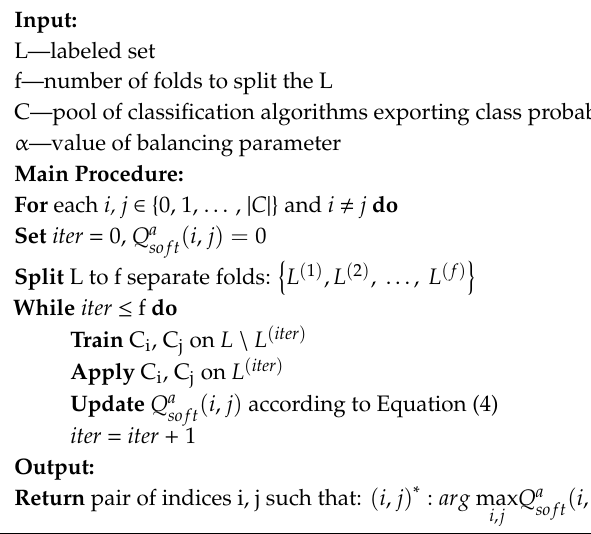
Algorithm 1. SSoftEC strategy